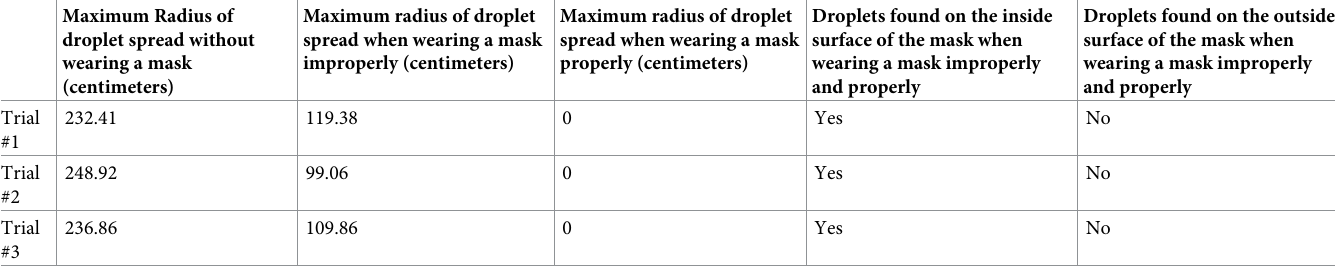
Table 6. (Experiment 6, Experiment 7, Experiment 8): Droplet spread with and without a surgical mask. Maximum Radius of droplet spread without wearing a mask